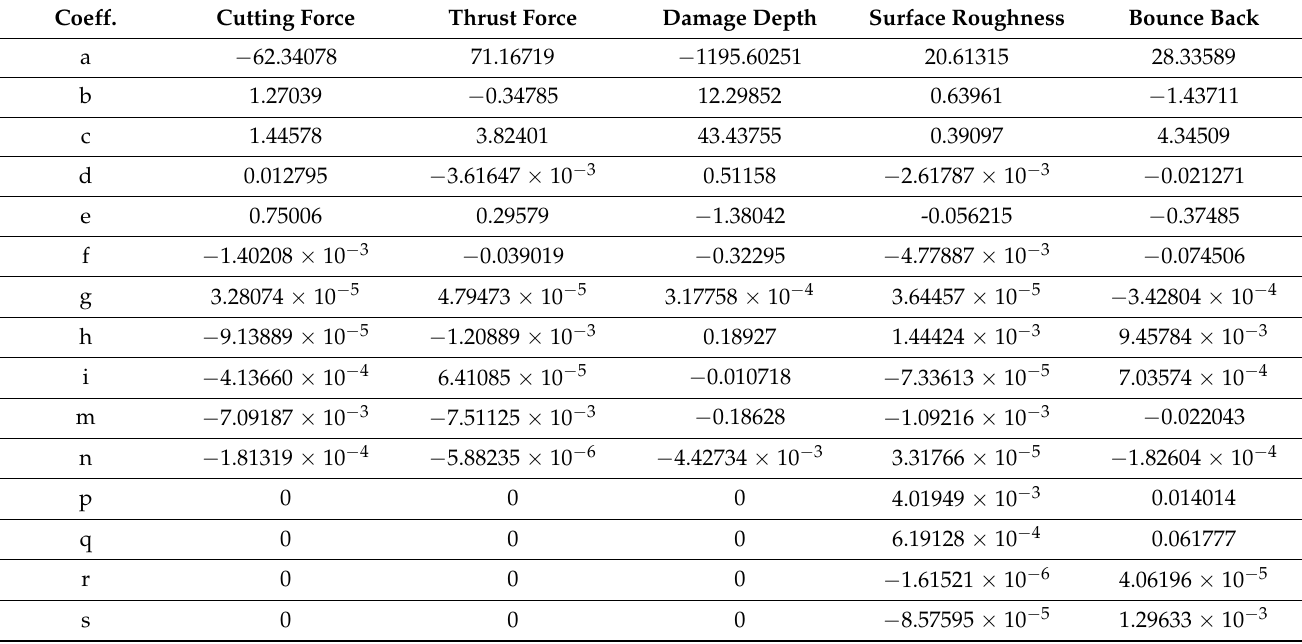
Table 7. Model coefficients for each output